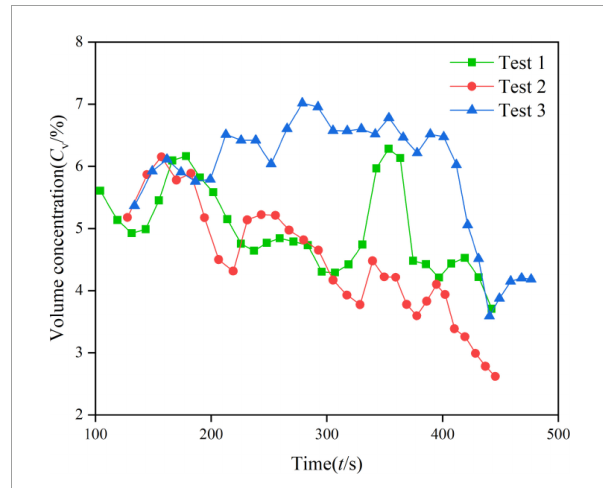
FIGURE3 Volume concentration of parallel experiments.